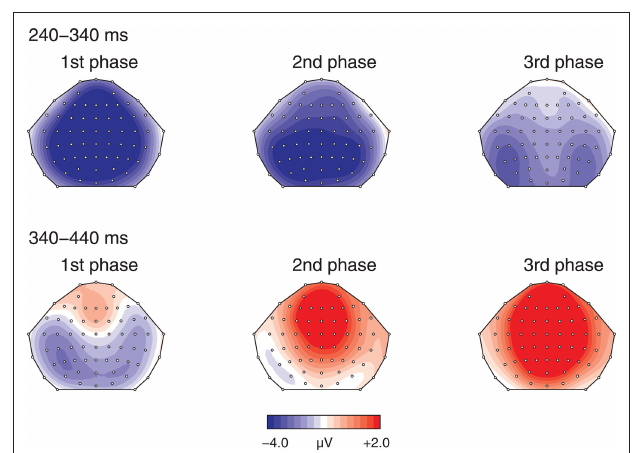
FiguRE 4 | Topographic maps illustrating learning related changes in scalp distribution of the difference waves (negative–positive) in the